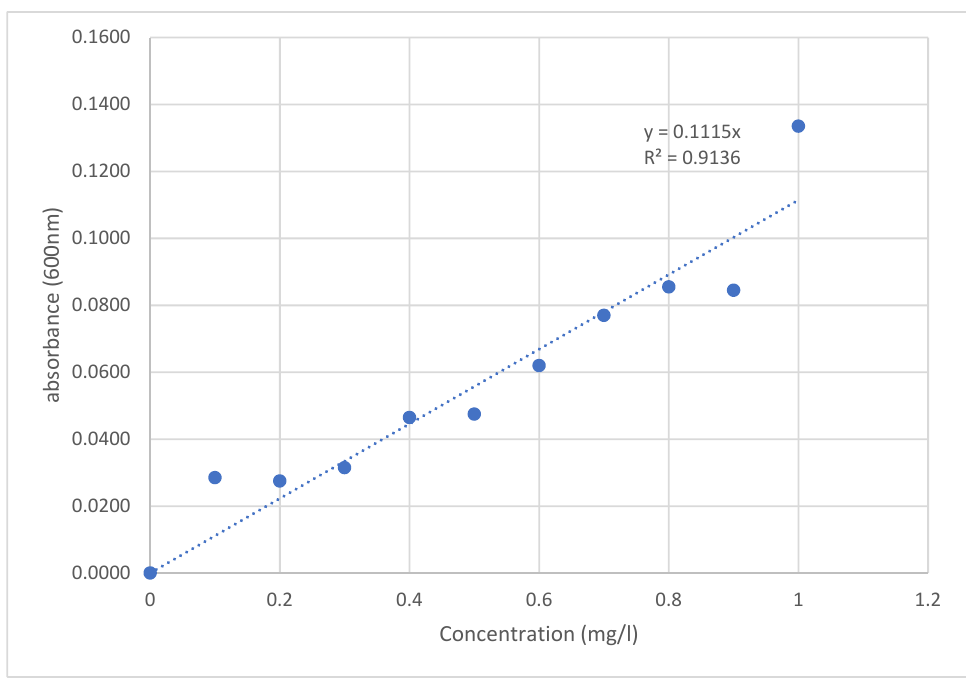
Figure A1. Standard calibration curve of chicken manure.